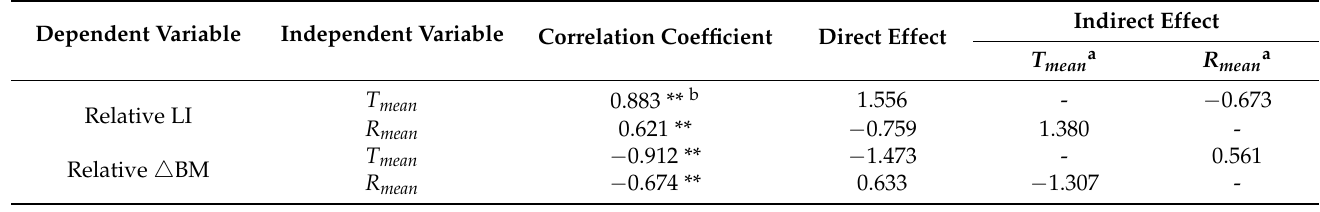
Table 4. The direct and indirect effects of the T mean and R mean on the relative LI and (cid:52) BM of twelve indica rice